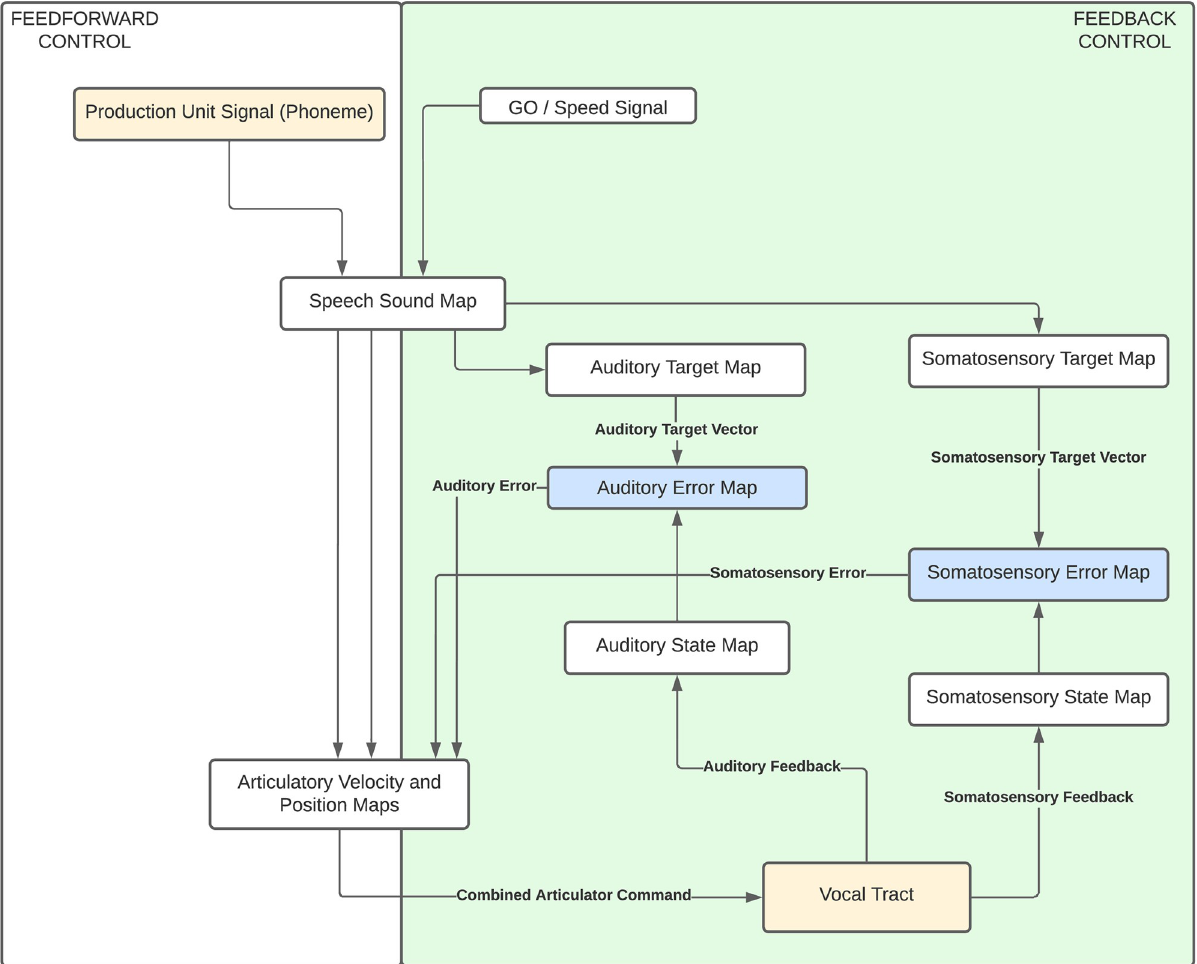
Fig 1. DIVA model architecture. Simplified schematic view of the DIVA model, showing the combination of feedforward and feedback control loops.